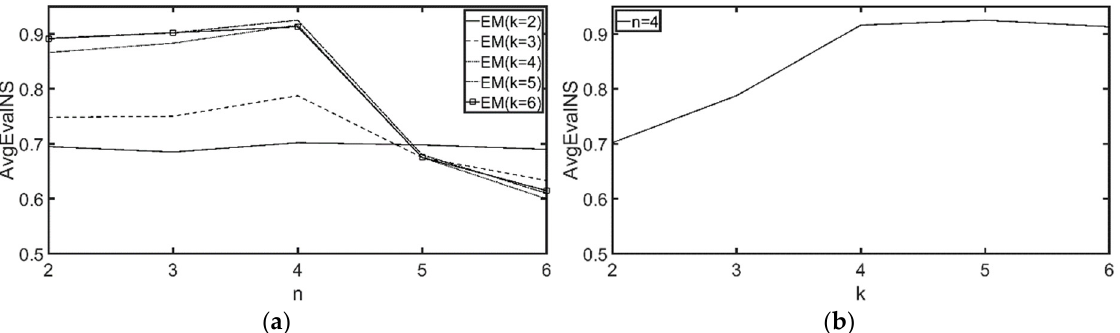
Figure 17. AvgEvalNS with ( α k = 4, α n = 4, NA) resulting from different k , n. ( a ) resulting from different n . ( b ) resulting from different k .